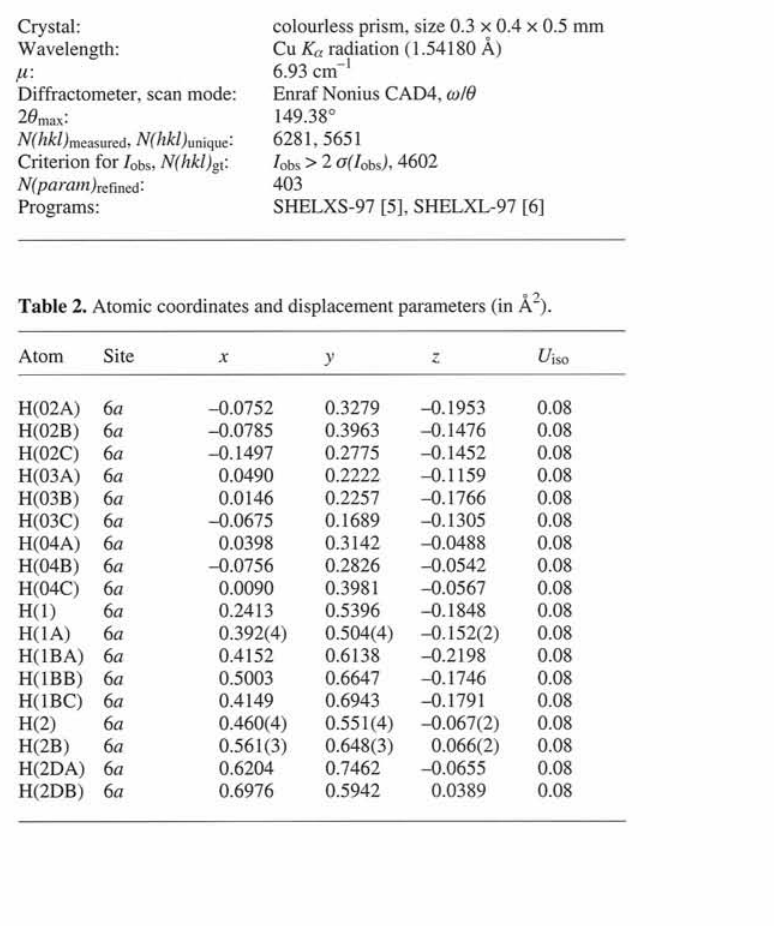
Table 1. Data collection and handling.